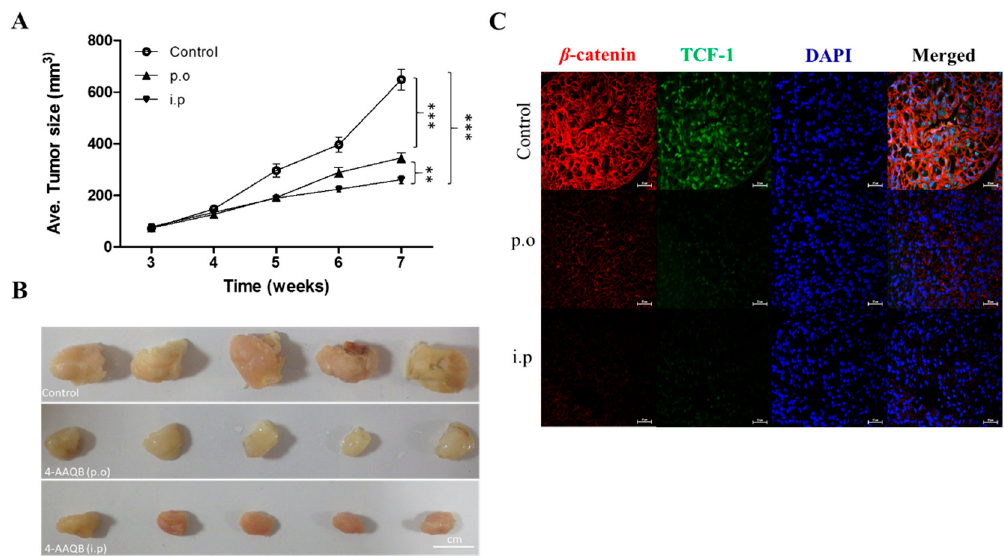
Figure 7. Compared to oral gavage, intraperitoneal 4-AAQB significantly and more efficiently suppresses GBM stem cell-induced tumor growth, in vivo. ( A ) Tumor size vs time curve show the inhibitory effect of 4-AAQB on U87MG tumor growth either via p.o or i.p route, as compared to the control group. ( B ) Photographs of tumor samples harvested from the in vivo studies. ( C ) The differential effects of oral and intraperitoneal administration of 4-AAQB on the expression and localization of TCF-1 and β -catenin in xenograft-derived GBM primary culture. * p < 0.05, ** p < 0.01, *** p < 0.001; 4 ′ , 6 ′ -diamidino-2-phenylindole (DAPI) served as nuclear marker.